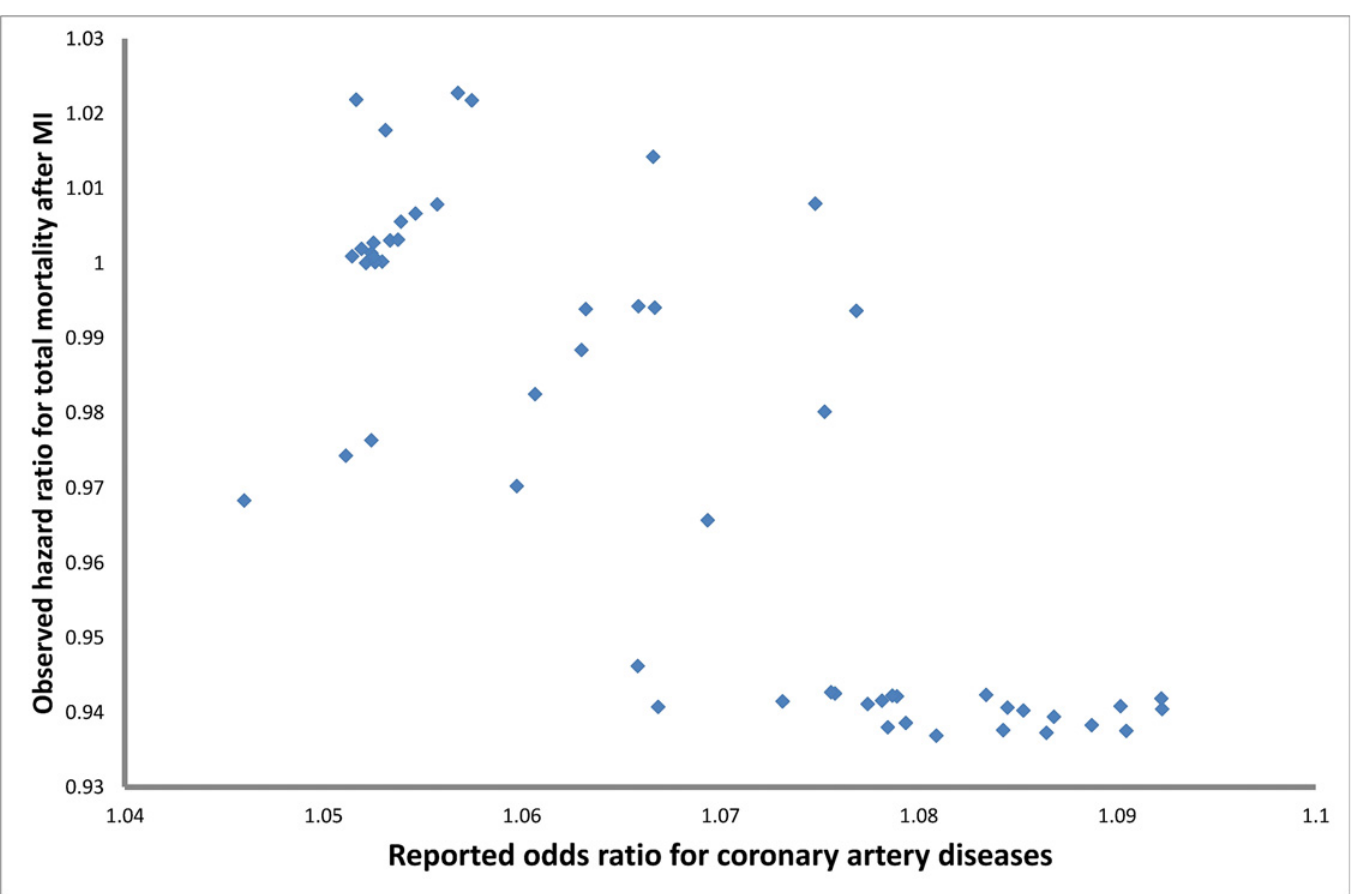
Fig 3. The association of top 79 SNPs with coronary artery disease as reported by CardiogramplusC4D for 9p21 locus and their association with total mortality after